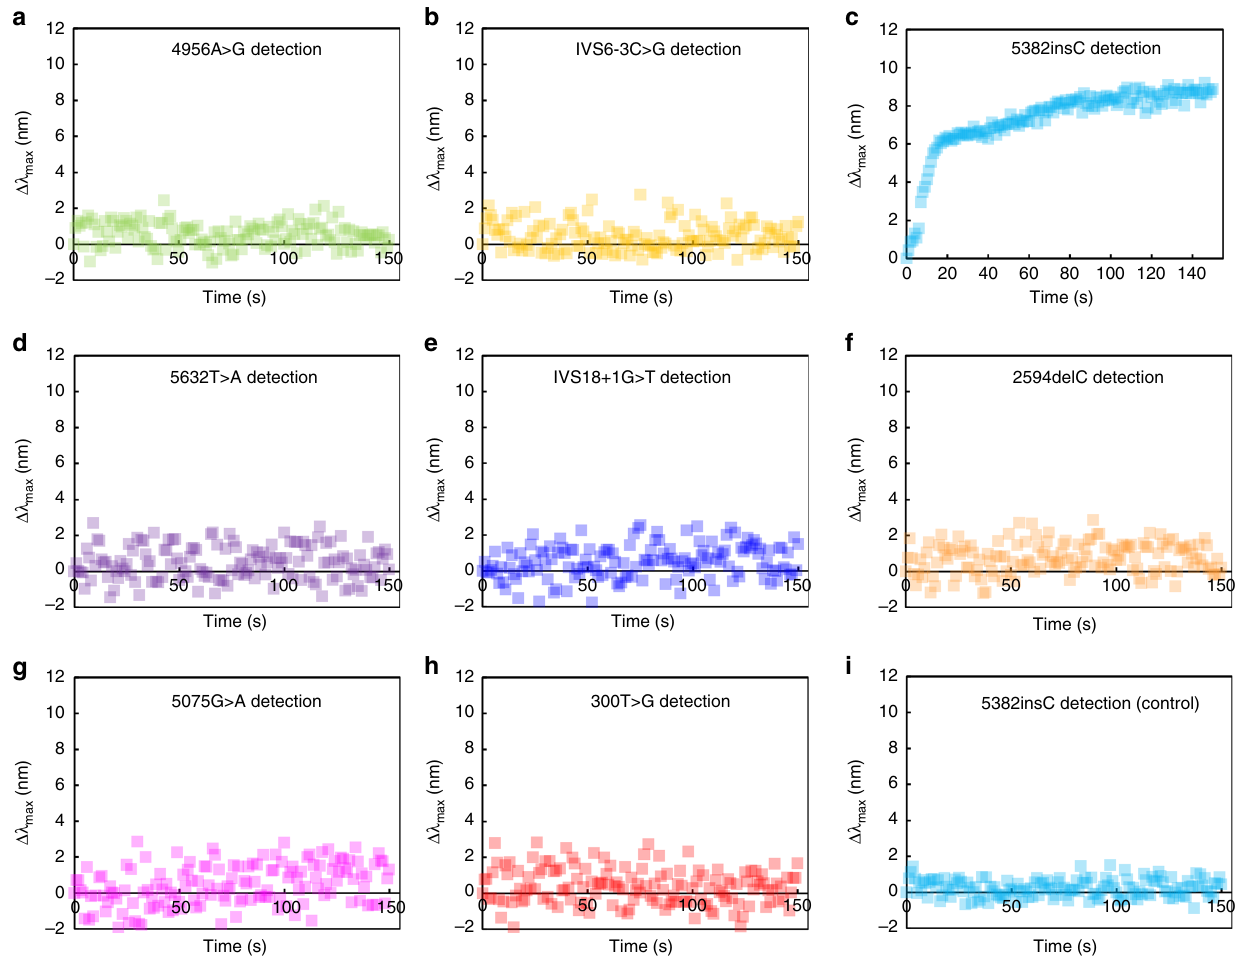
Fig. 6 Detections of BRCA1 point mutation with the eight single nanoparticle sensing (sNPS) chips developed in this study. a – h The sample from human breast cancer cell line, HCC1937, was detected as the analyte. None of the chips yielded an effective k reaction except the 5382insC, indicating that the analyte contains a single cytosine duplication. i The sample from MCF7 was detected as the control. Source data are provided as a Source Data fi